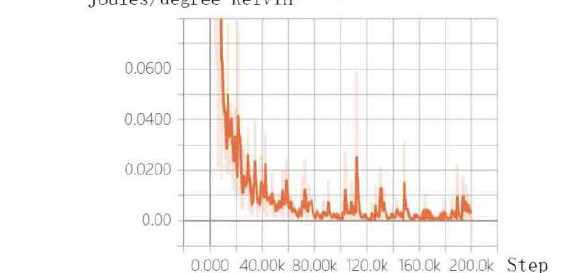
Figure 4. Box classifier localization loss of the extraction result